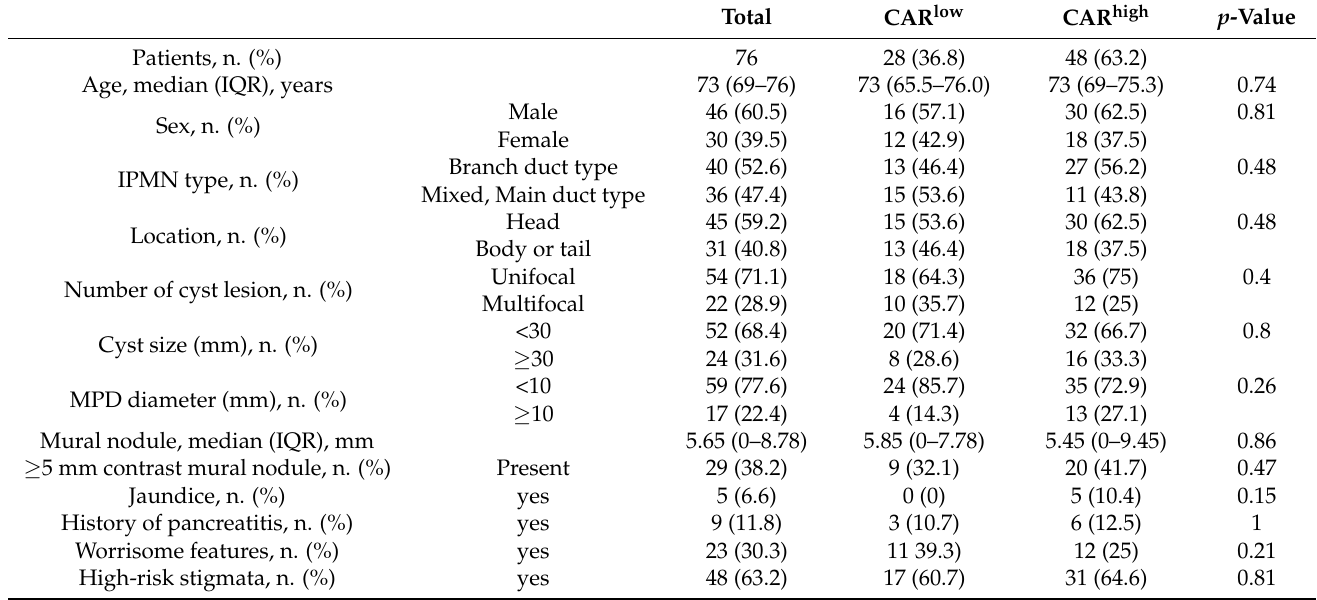
Table 2. Comparison of clinical characteristics between CAR low and CAR high . Total CAR low CAR high p